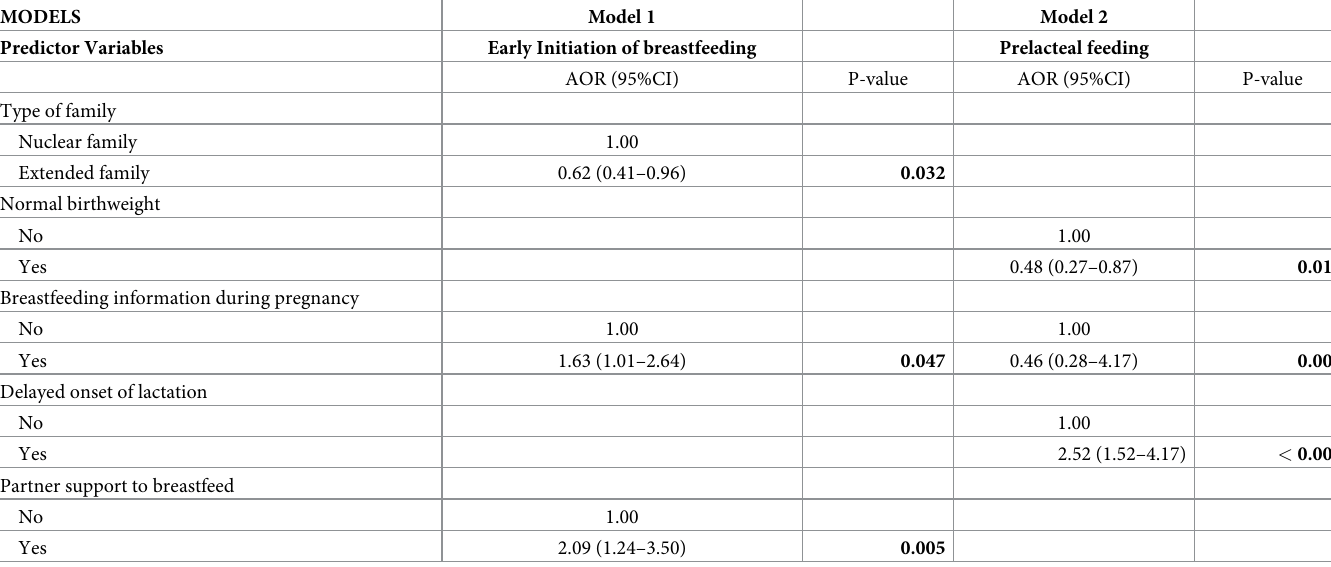
Adjusted Odds Ratio; Model 1 examined the relationship between predictor variables and early Initiation of breastfeeding, Model 2 examined the relationship between predictor variables and Prelacteal